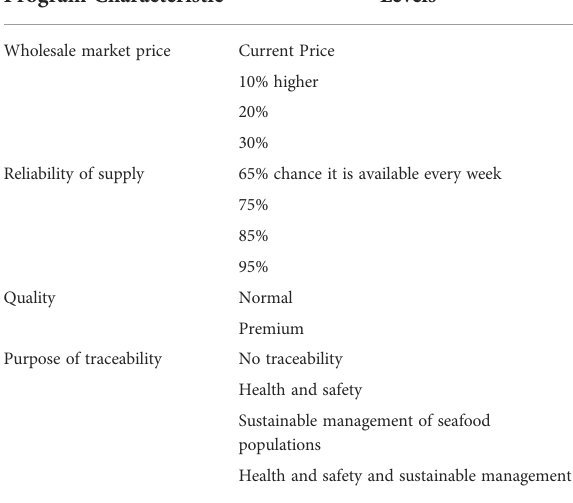
TABLE 1 Voluntary seafood program for restaurants with four attributes and levels